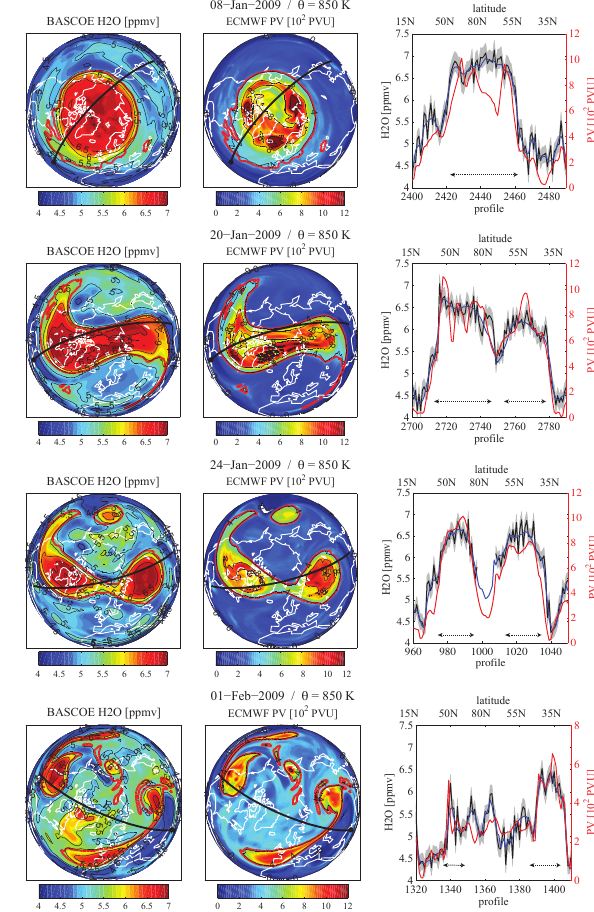
Fig. 5. As Fig. 4 but at 850K. The PV field is depicted in 10 2 ×